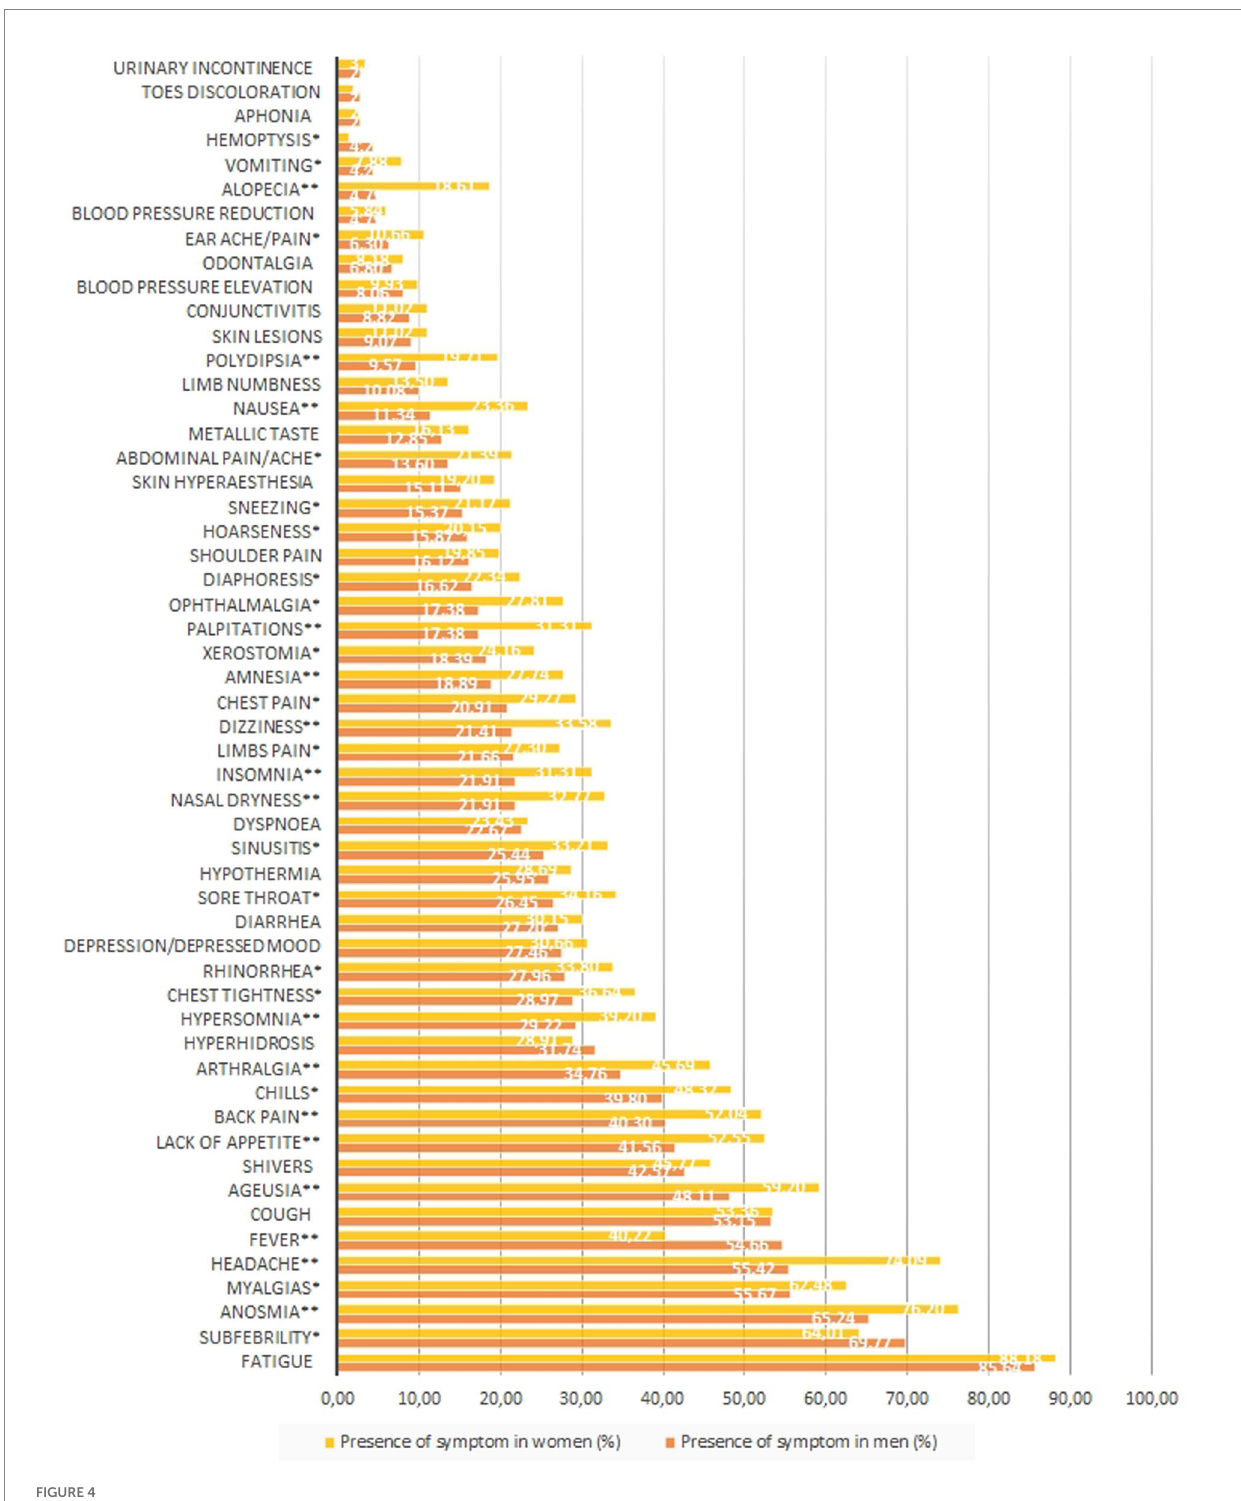
FIGURE 4 Prevalence of COVID-19 symptoms among men and women in studied population. * p <0.05, ** p